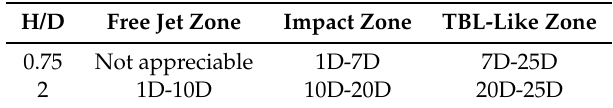
Table 1. Jet-plate interaction zones. TBL: turbulent boundary